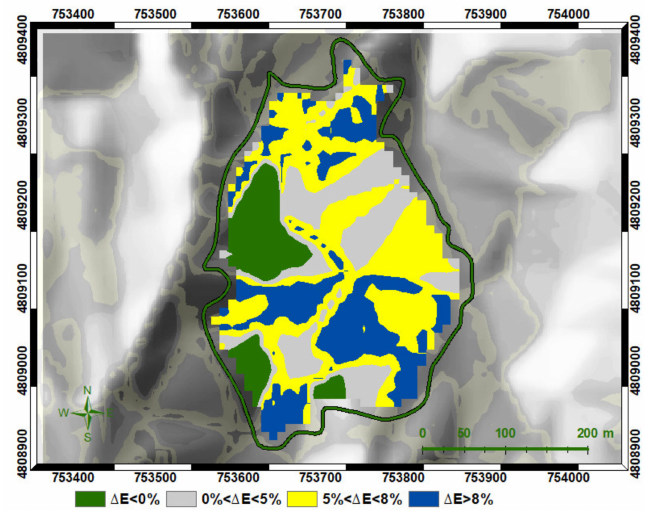
Figure 8. Map showing the spatial distribution of ∆ E evaluated at the end of the rainfall